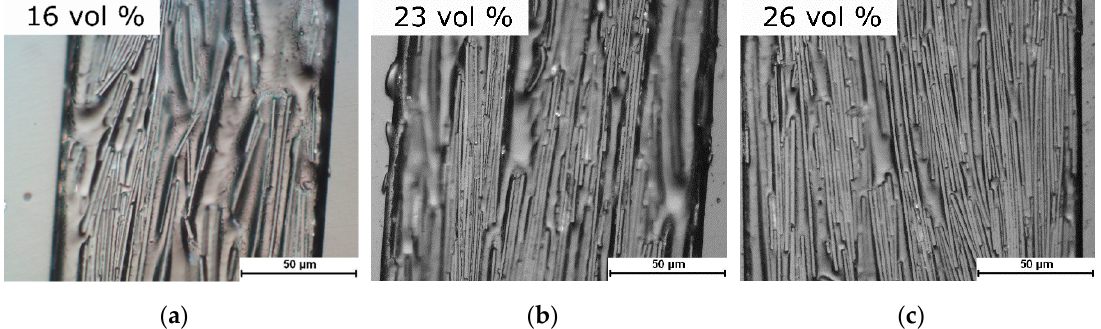
Figure 11. Cross-section of PVB–MGF composites with ( a ) 16, ( b ) 23 and ( c ) 26 vol % of GF100 glass flakes and an average thickness of y ~120–150 µm. The alignment of the flakes parallel to the sample surface is increased with volume content.